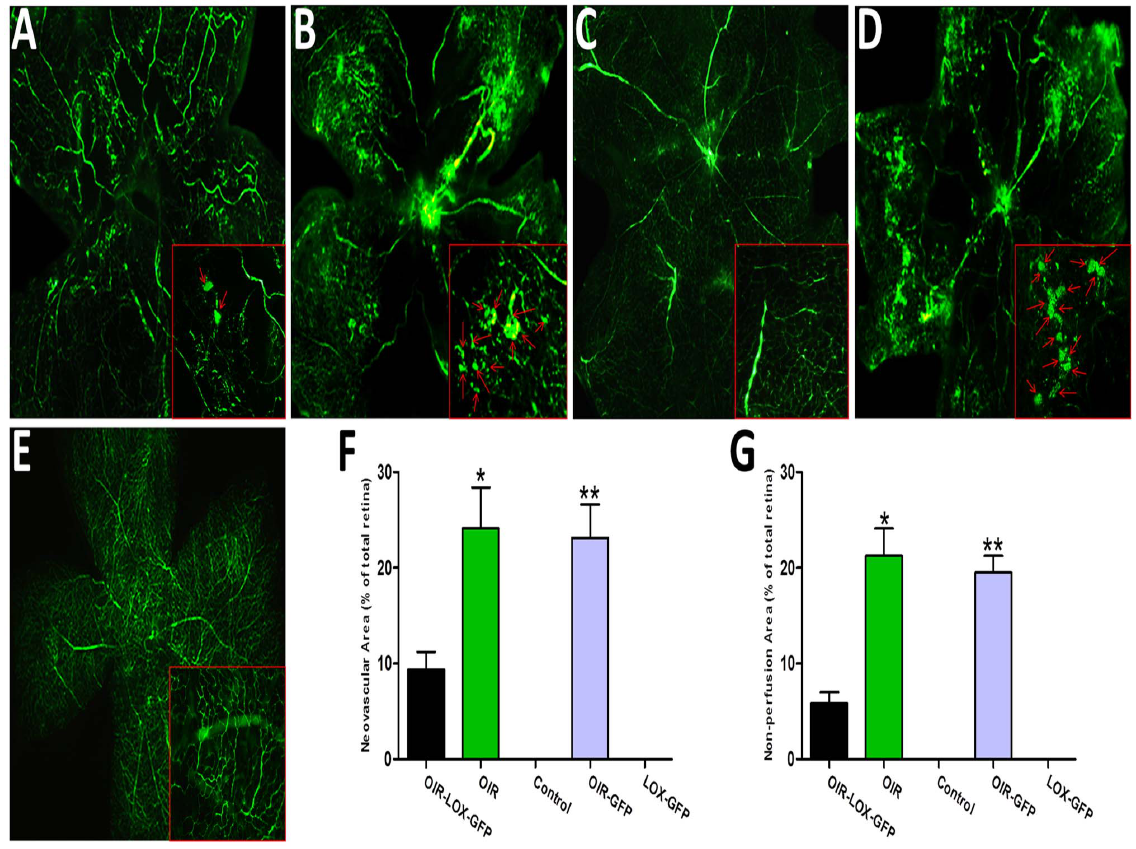
Figure 4. Effects of 15-LOX-1 gene transfer on retinal neovascularization in the oxygen-induced ischemic retinopathy model. Mice were perfused with fluorescein isothiocyanate-dextran at postnatal day 17 and the retina flat mounted. A: OIR-LOX-GFP group, B: OIR group, C: Control group, D: OIR-GFP group, E: LOX-GFP group. Magnification 6 40. The red rectangles in each figure are the magnification of randomly selected foci of the retina, and the red arrows indicate the neovascular tufts. F: Quantification of the neovascularization in the retinas from OIR-LOX-GFP group, OIR group, Control group, OIR-GFP group and LOX-GFP group mice. Retinal neovascularization was quantified by measuring the ratio of the neovascular tuft area to the total retinal area using the Image-Pro Plus 6.0 software (means 6 SD). OIR-LOX-GFP group versus OIR group *p , 0.05; OIR-LOX-GFP group versus OIR-GFP group **p , 0.05, n=8. G: Retinas non-perfusion areas were measured and compared with OIR-LOX-GFP group, OIR group, Control group, OIR-GFP group and LOX-GFP group using the Image-Pro Plus 6.0 software (means 6 SD). OIR-LOX-GFP group versus OIR group *p , 0.05; OIR-LOX-GFP group versus OIR-GFP group **p , 0.05, n=8.